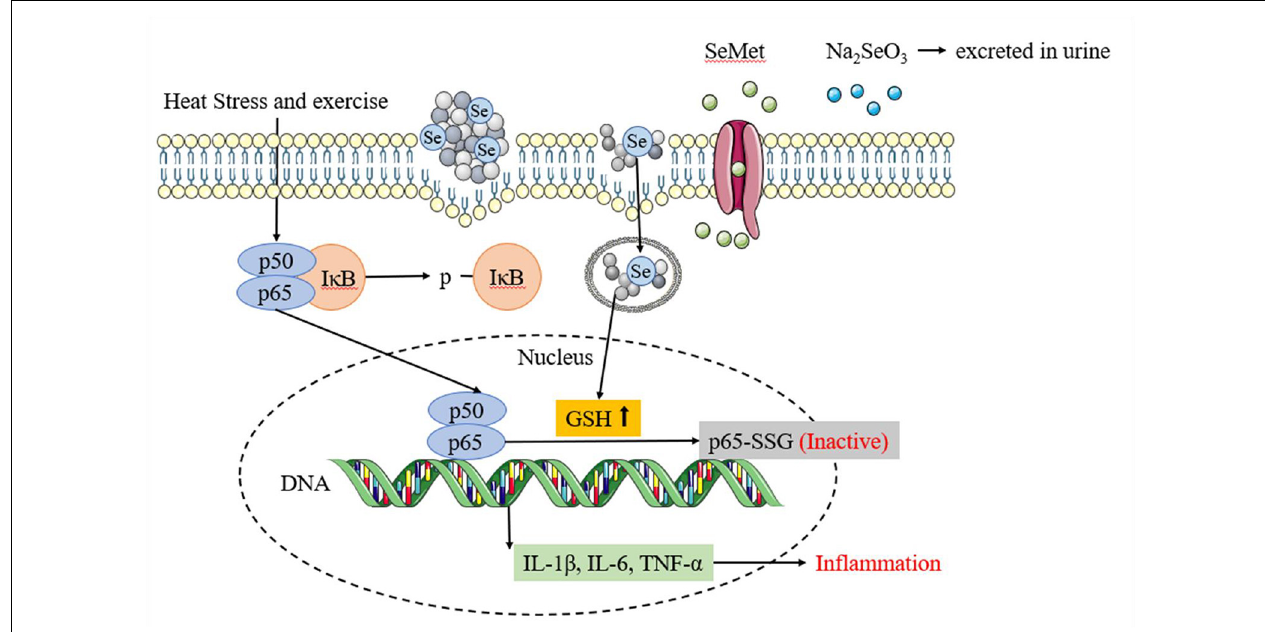
FIGURE 7 | Different selenium supplements inhibits inflammatory response by affecting NF- κ B/I κ B signaling pathway.